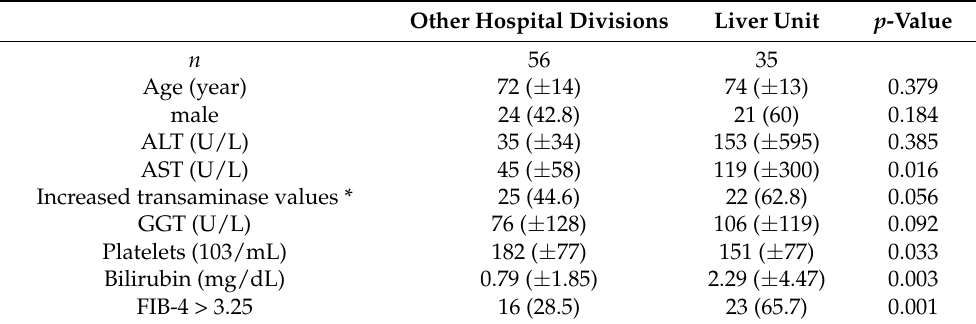
Table 2. Biochemical characteristics of patients with active infection admitted to liver unit and to other hospital